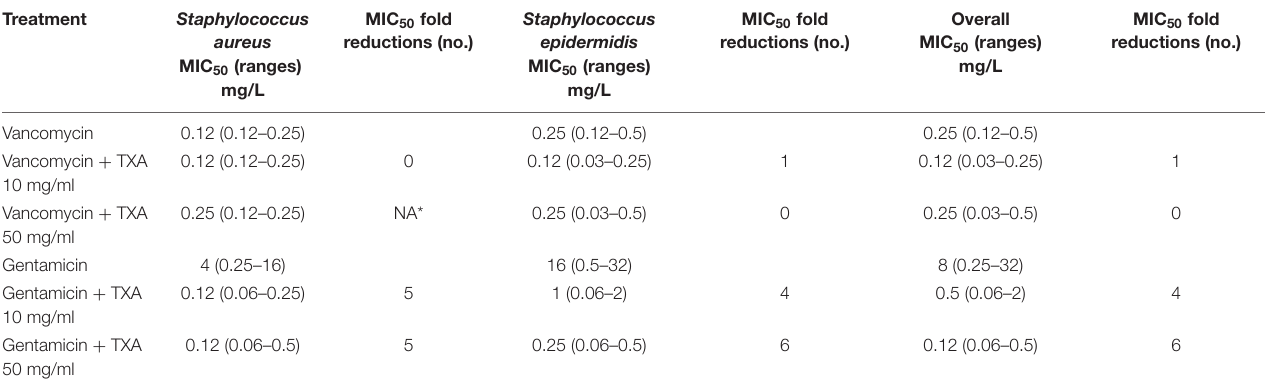
TABLE 1 | MIC 50 for vancomycin and gentamicin alone and in combination with tranexamic acid (TXA) using the standard visualization method.